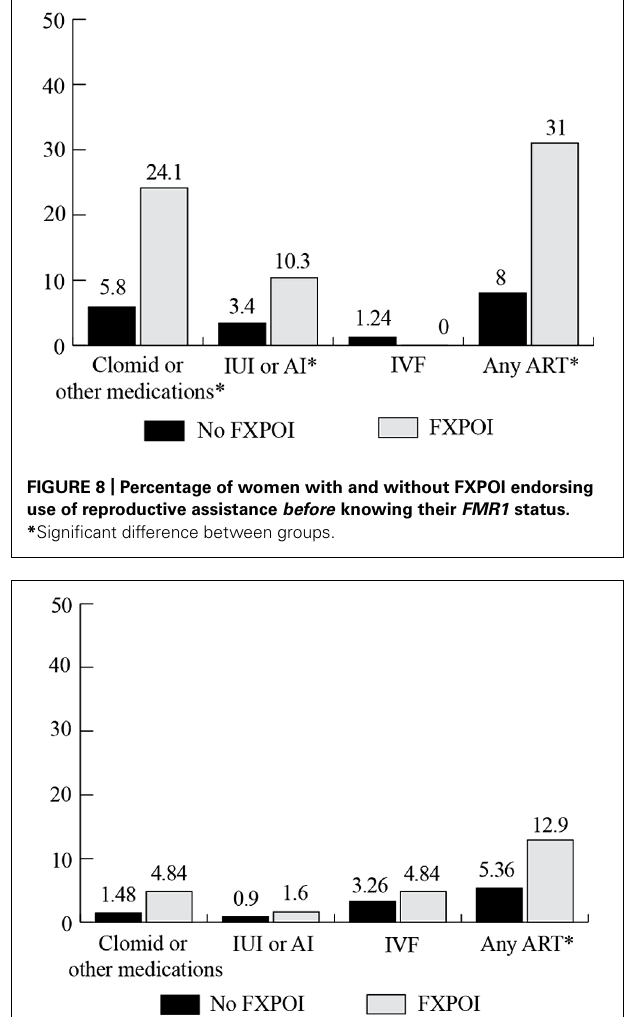
FIGURE 9 | Percentage of women with and without FXPOI endorsing use of reproductive assistance after knowing their FMR1 status. *Significant difference between